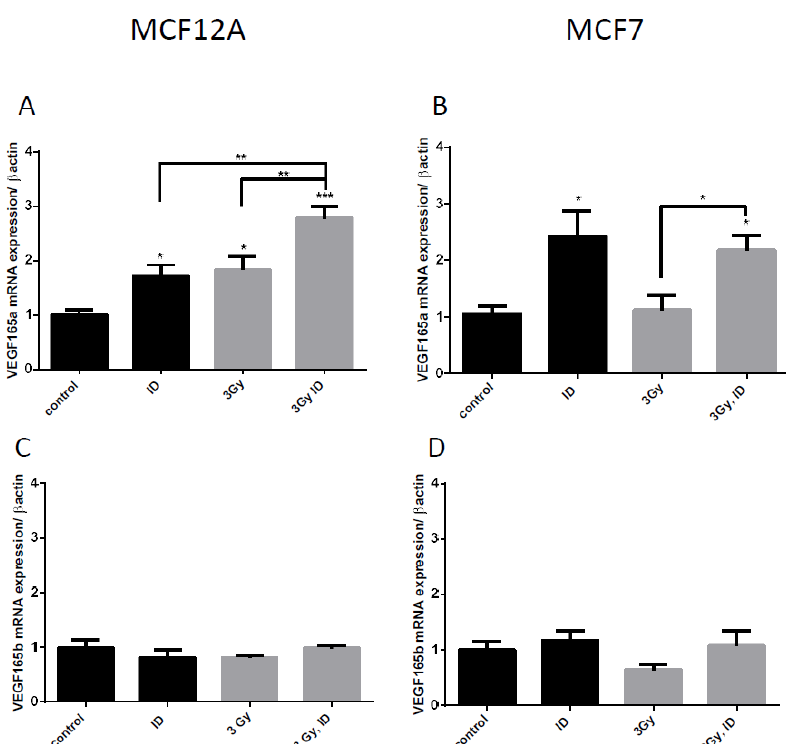
Figure 4. ID and irradiation modifies VEGF alternative splicing in breast cells. Cells were cultured in iodine-containing medium for 7 days. Thereafter, the medium was replaced by iodine-containing (control) or iodine deficient (ID) medium and cells were then irradiated with a dose of 0.1 or 3 Gy. Cells were harvested 4 ( A , C ) or 6 h ( B , D ) after medium change. VEGF 165 (A, B) and VEGF165b (C, D) mRNA expression in MCF12A (A, C) and MCF7 cells (B, D) was determined using RT-qPCR. Data are expressed as means ± SEM. p -values < 0.05 were considered as statistically significant. * p < 0.05,